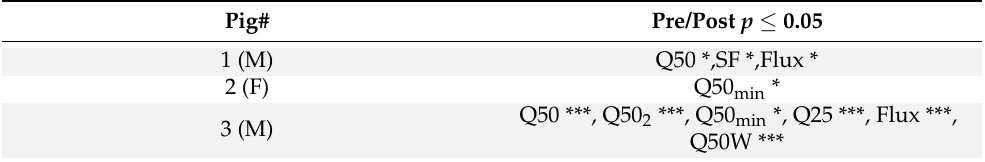
Table 3. Statistically significantly changing parameters for all pre/post-surgery